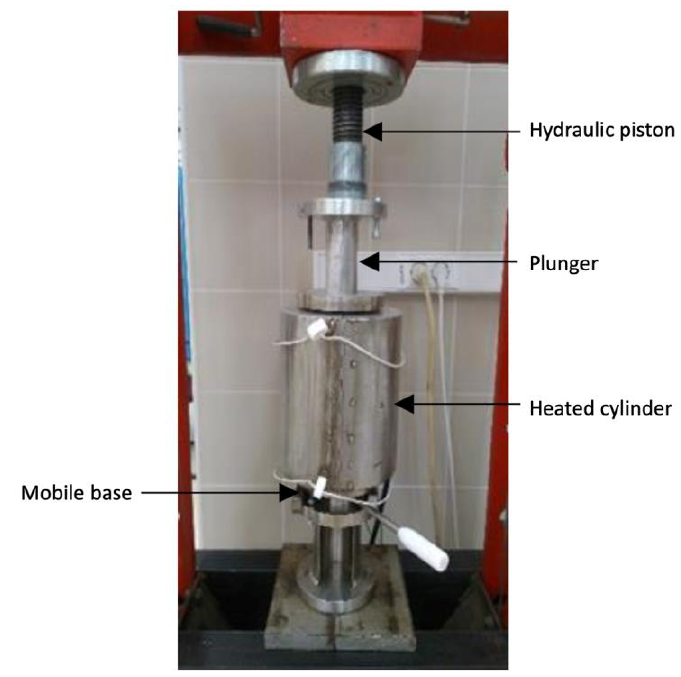
Figure 3. Briquetting machine and heating system.